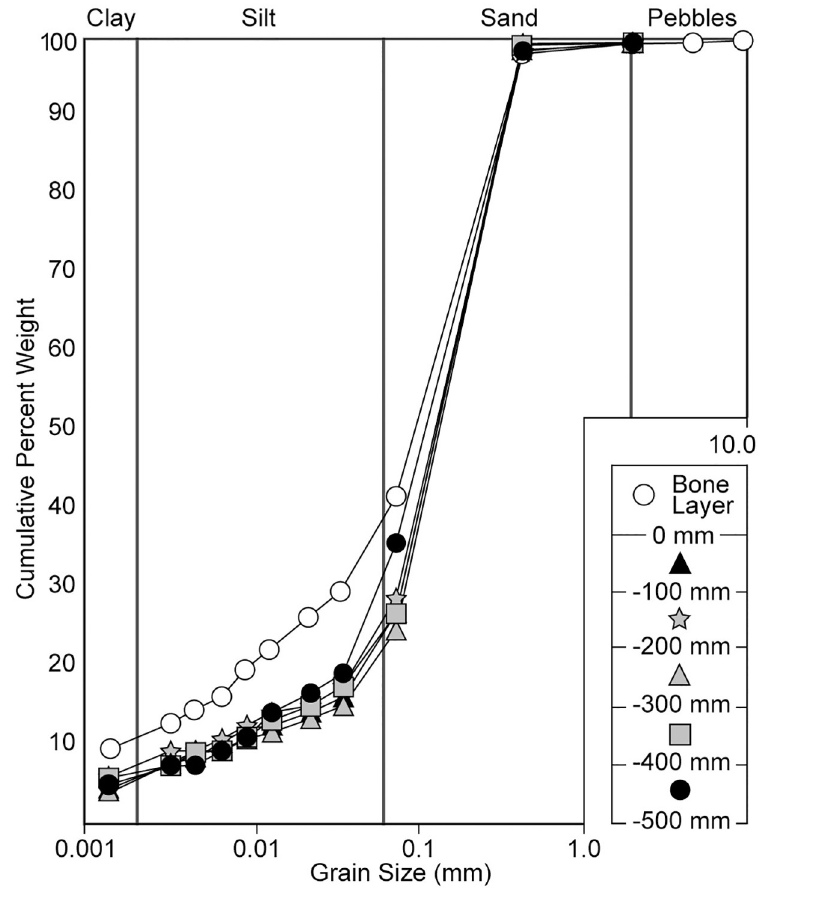
Fig 9. Grain size analysis of the rocks below and at the fossil layer preserving NDGS